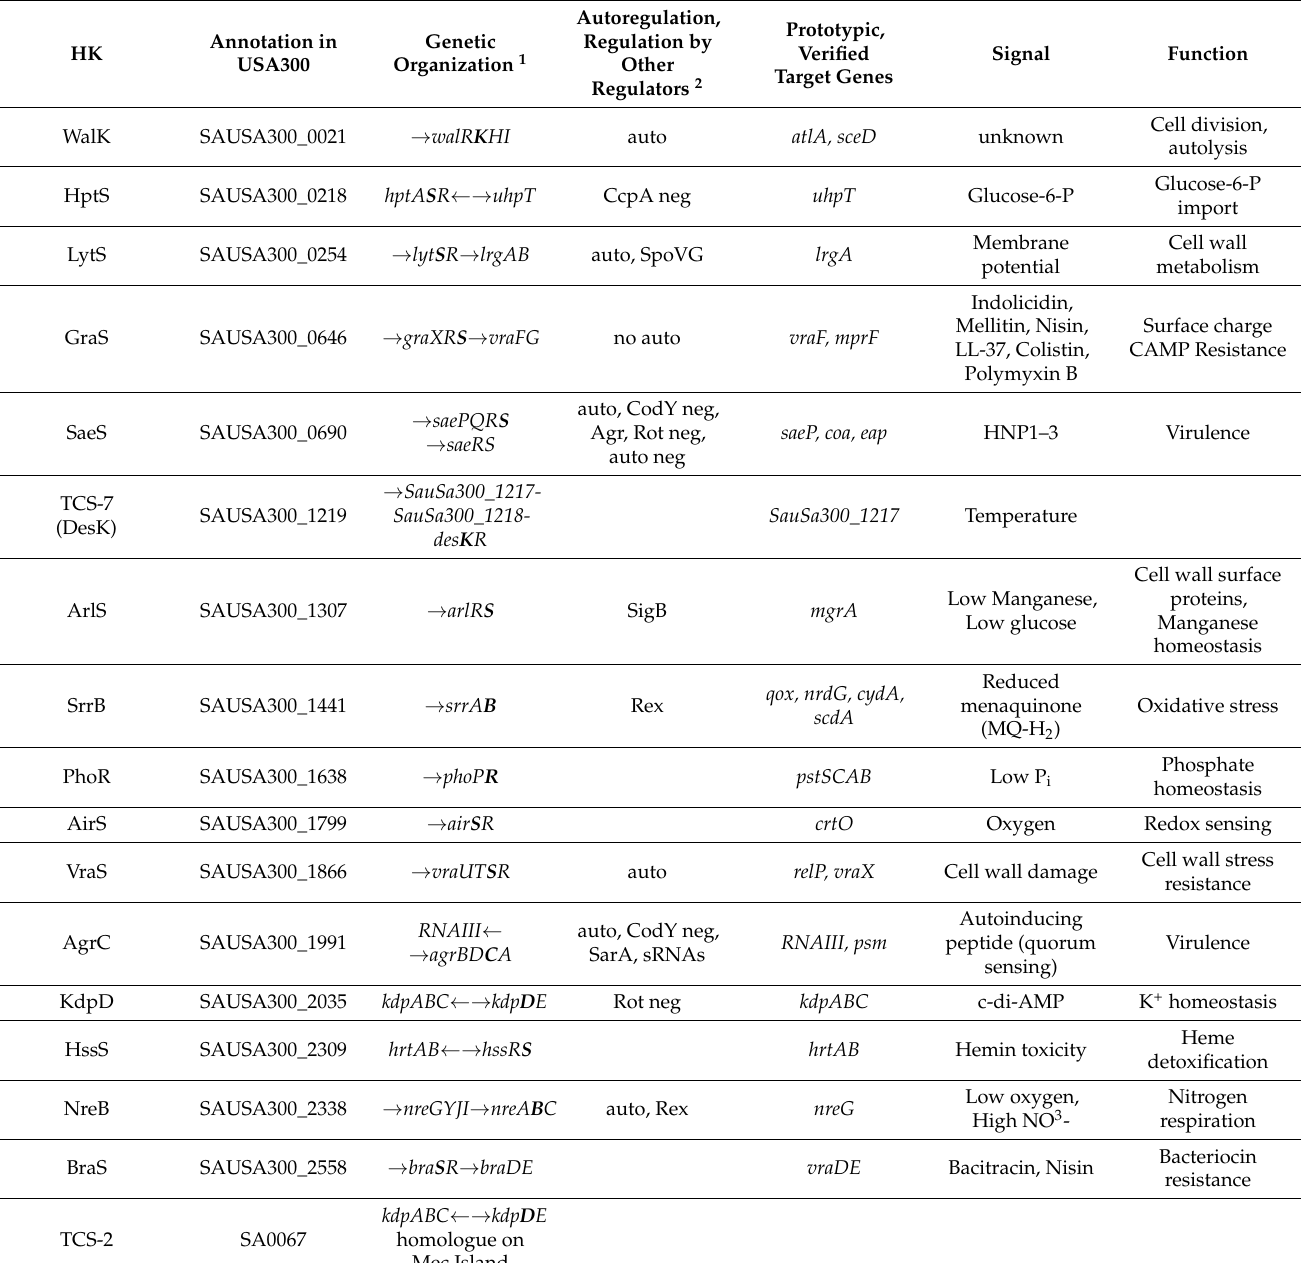
Table 1. Genetic organization, regulation, and function of S. aureus